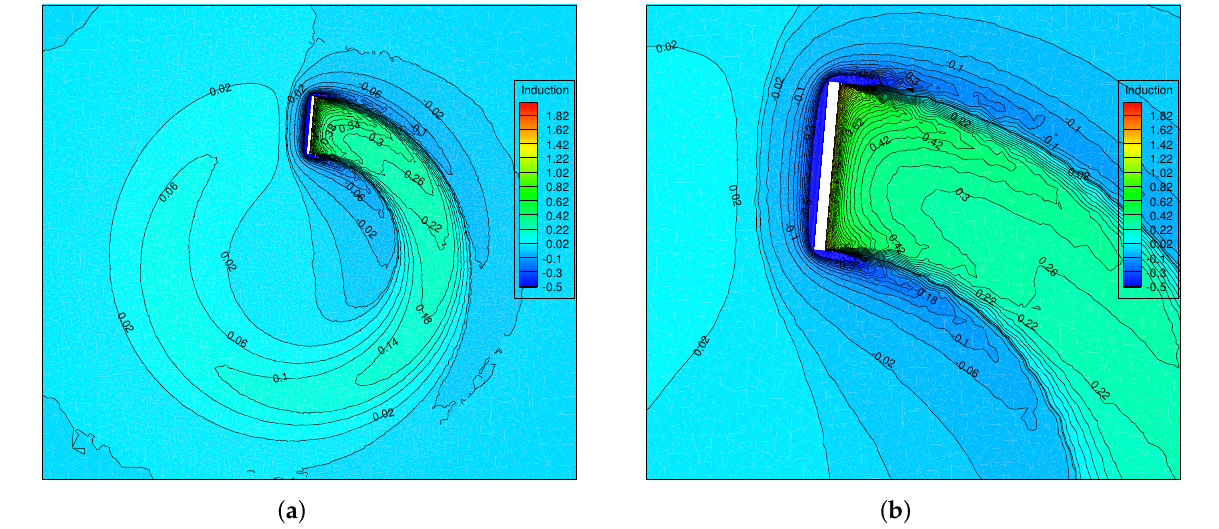
Figure 3. ( a ) Contour plots showing the axial induction factor distribution for an instant of a cycle at the kite location. The white rectangular region in the plots represents the kite. The subfigure ( b ) shows a close-up